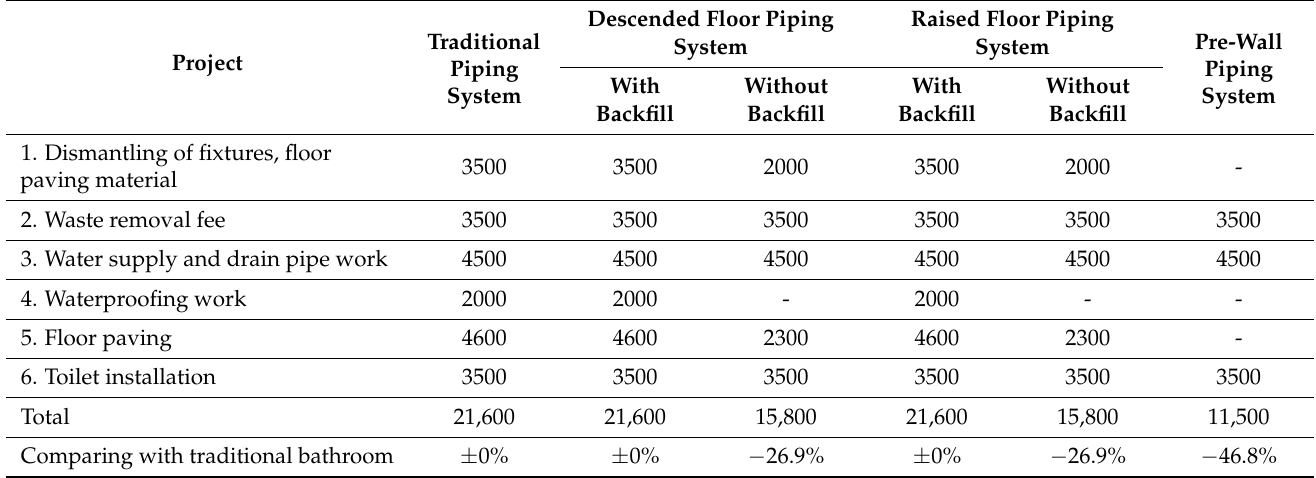
Figure 10. Life cycle costs for the complete replacement of pipelines in the four types of bathroom piping systems after changing the traditional piping system to the raised floor piping system with backfill, with discount rate of − 0.01%. Table 3. Costs for partial replacement of pipelines in the four types of bathroom piping